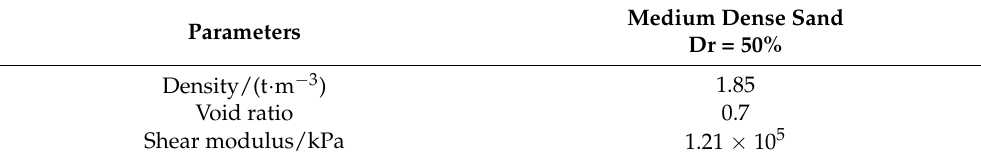
Table 5. Parameters of PDMY02